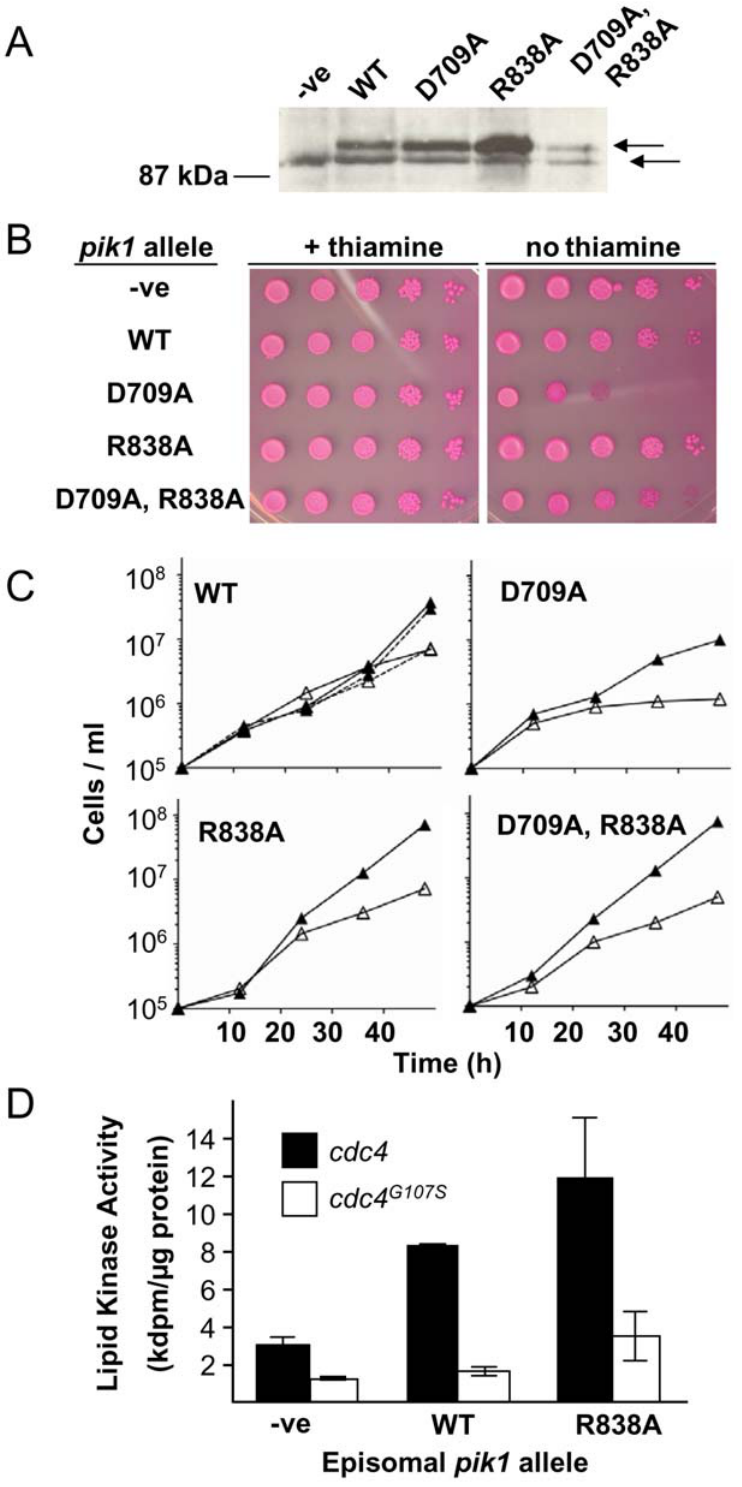
Figure 9. Effects of ectopic expression of pik1 alleles in cdc4 G107S cells. (A) Immunoblot assay. Accumulation of Pik1 in cdc4 G107S cells upon ectopic expression of pik1 alleles from an episome under the control of the nmt1 promoter in cells carrying the intact chromosomal pik1 locus was assessed by immunoblot analysis as described for Figure 6C. Results shown are representative of 3 separate experiments with the same strains. Colony formation assays (B) and proliferation in liquid medium (C) of S. pombe cdc4 G107S cells transformed with the pREP1 plasmid with no insert (-ve), or with the pREP1 plasmid carrying pik1 (WT), pik1 D709A (D709A), pik1 R838A (R838A), or pik1 D709A, R838A (D709A, R838A) were carried out as described in Figure 8A and B. (D) Lipid kinase activity assays. Cells carrying either cdc4 or cdc4 G107S were transformed with a pREP1 plasmid with no insert (-ve), or with wild-type pik1 wt (WT) or pik1 R838A (R838A) cDNA sequences. Cells were incubated at 25 u C for 24 hours in the absence of thiamine, and lysates prepared and assayed immediately for lipid kinase activity as described in Figure 7. Results shown are mean 6 S.E. of at least 3 separate experiments with the same strains. doi:10.1371/journal.pone.0006179.g009 PLoS ONE |